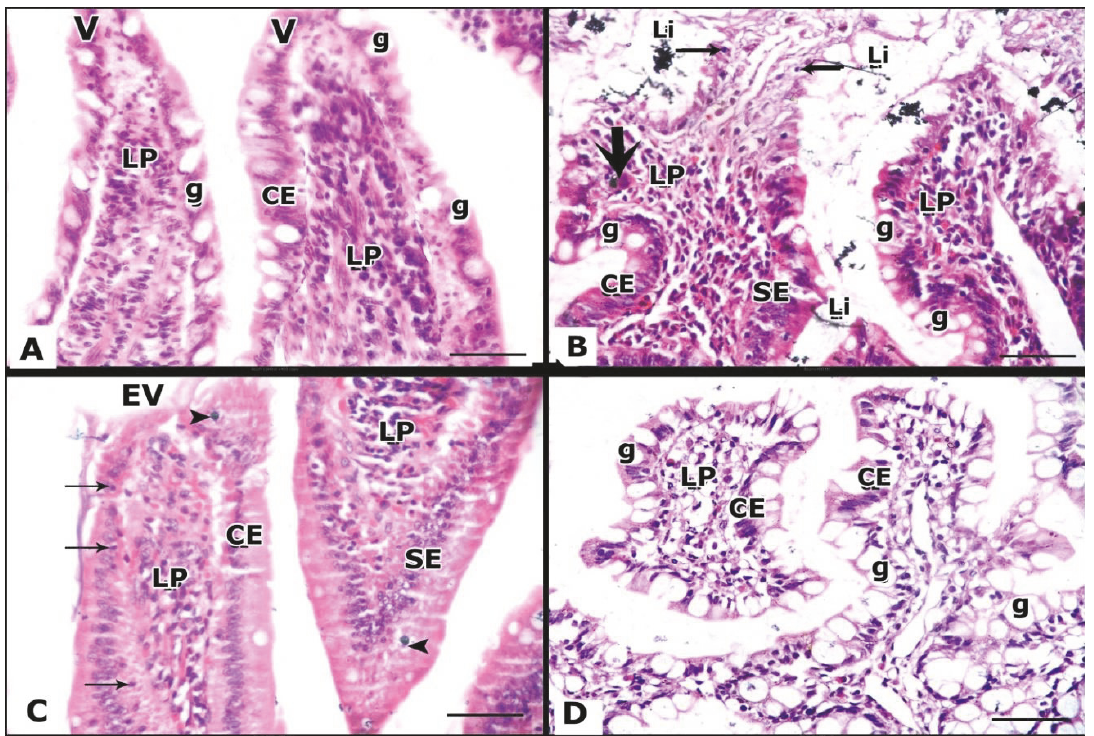
Figure 2: Representative photographs of the histologic sections of ileal tissues obtained from the studied groups. A: The ileal parts from control group show normal histological architecture, while villi appear widely separated villi ( V ) and lined by columnar cell with basal oval nuclei( CE ),numerousgobletcells( g )andlaminapropria( LP )withabundantcellularelementscanbeseen. B :Theilealtissuesofironoverload group show eroded villi with epithelial lining loss, numerous goblet cells ( g ), areas with single columnar layer ( CE ), and areas with stratified epithelial lining ( SE ) and intraepitheliallymphocytes ( thin arrow ) are observed. Lamina propria ( LP ) with giant iron laden cell ( thick arrow ) are clarified. Luminal iron ( Li ) in crystalline and linear forms is observed. C: The ileal tissues of iron + DFO treated group show an eroded villus ( EV ). Villi with areas with single columnar layer ( CE ) are areas with stratified epithelial lining ( SE ) are seen. Lamina propria ( LP ), intraepithelial lymphocytes ( arrow ) and iron deposit in epithelium or lamina propria ( arrow head ) are observed. D : ileal tissues of iron+ Quercetin-treated group show villi with numerous goblet cells ( g ), while single columnar layer ( CE ) and lamina propria ( LP ) are clarified . (H&E ×